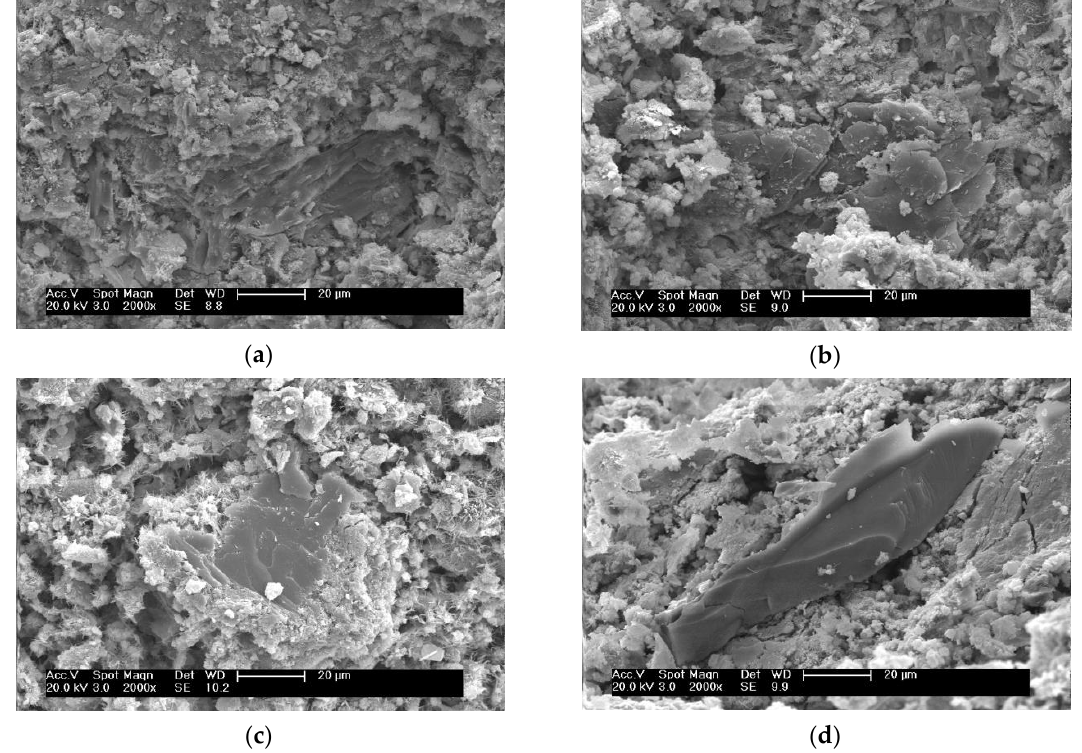
Figure 7. Scanning electron micrograph of hardened SSCC samples with different VPS: ( a ) S 0 SCC; ( b ) S 20 SCC; ( c ) S 60 SCC; ( d ) S 100 SCC.